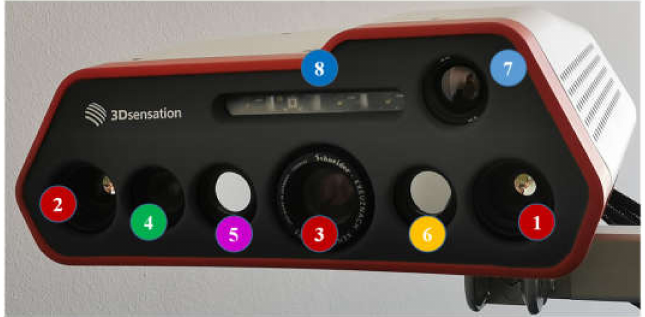
Figure 1. Multimodal 3D imaging system. 1 / 2: High-speed cameras at 850 nm, 3: High-speed GOes Before Optics (GOBO) projector at 850 nm, 4: Color camera, 5: NIR camera at 780 nm, 6: NIR camera at 940 nm, 7: Thermal camera, 8: Light emitting diode (LED) array at 780 and 940